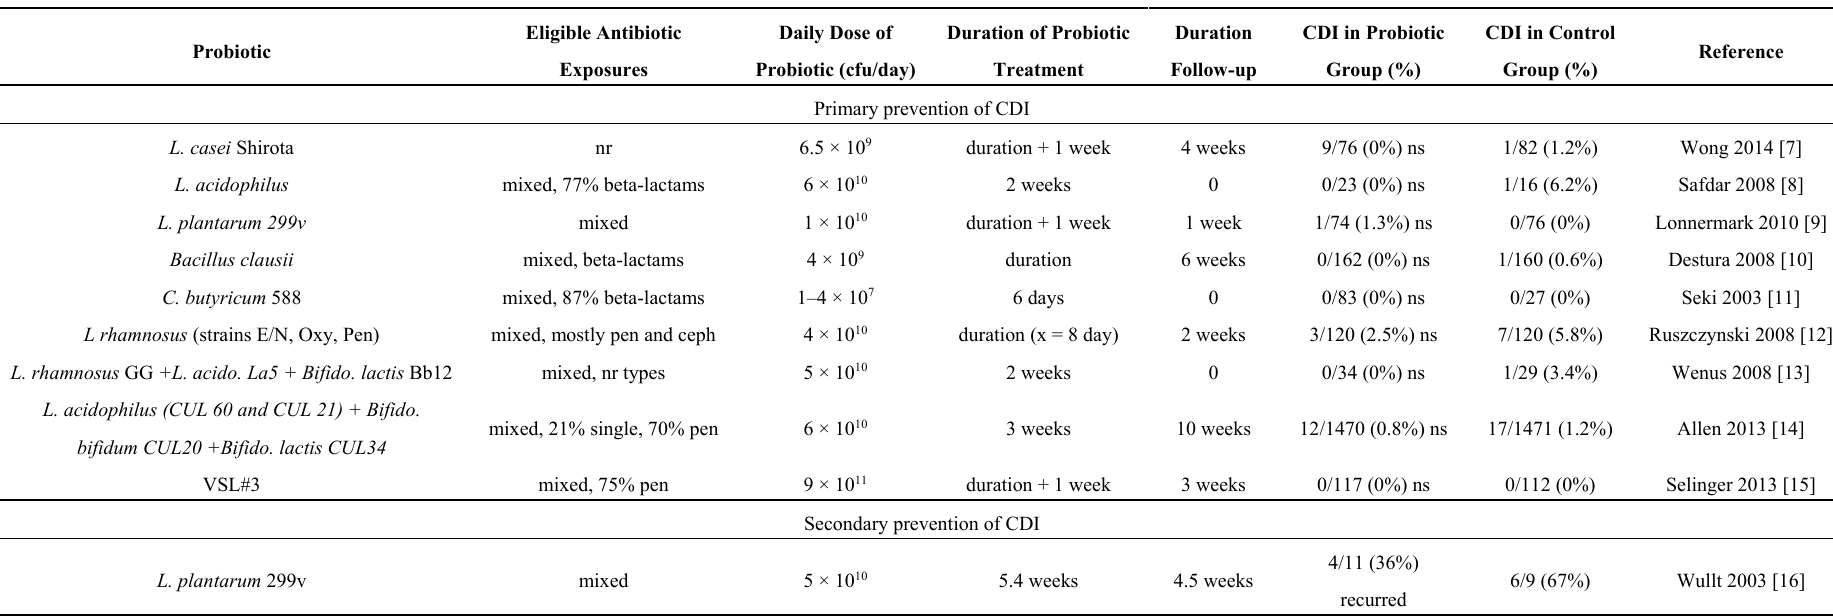
Abbreviations: Bifido., Bifidobacterium ; C., Clostridium ; cfu, colony-forming unit; L., Lactobacillus ; ns, not significant; VSL#3, contains Bifido. breve , Bifido. longum , Bifido. infantis , L. acidophilus , L. plantarum , L. casei , L. bulgaricus , Strept. thermophilus ; x,